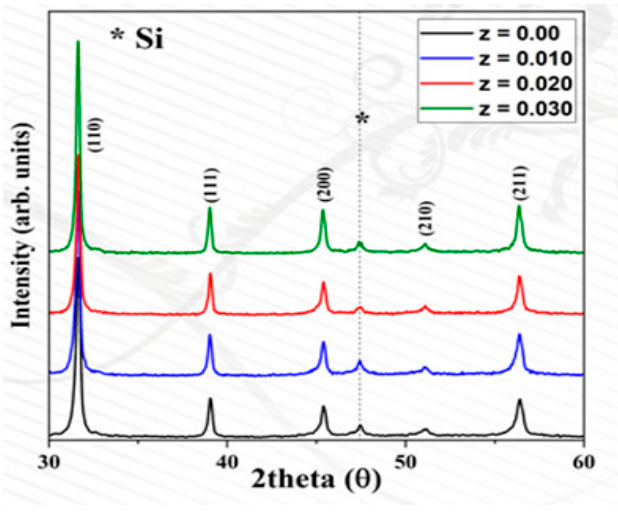
Figure 2. X–ray diffraction patterns for BFBT–zBCZT (z = 0.00–0.030) ceramics in the 2 θ ranges of 30–60° sintered at optimized conditions.